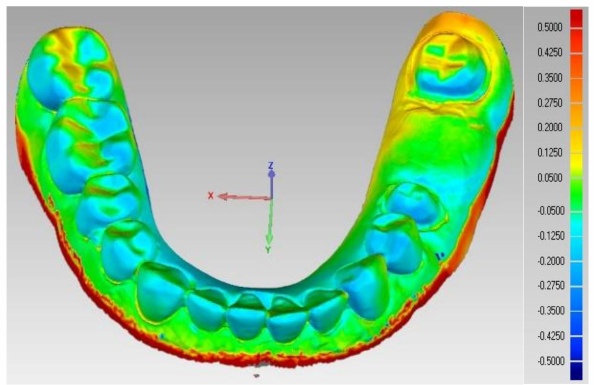
Figure 10. Color map representing the 3D accuracy of the test model compared to the control reference model.